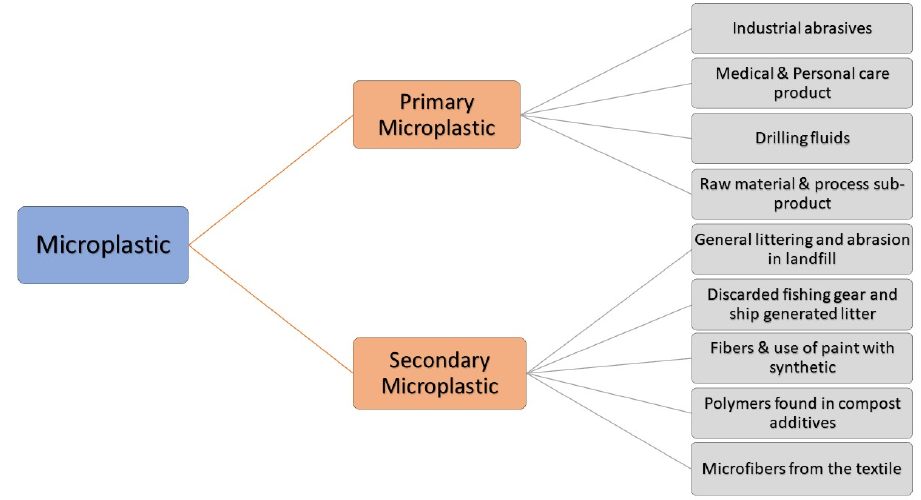
Figure 2. Main sources of primary and secondary microplastics. Adapted from [37].